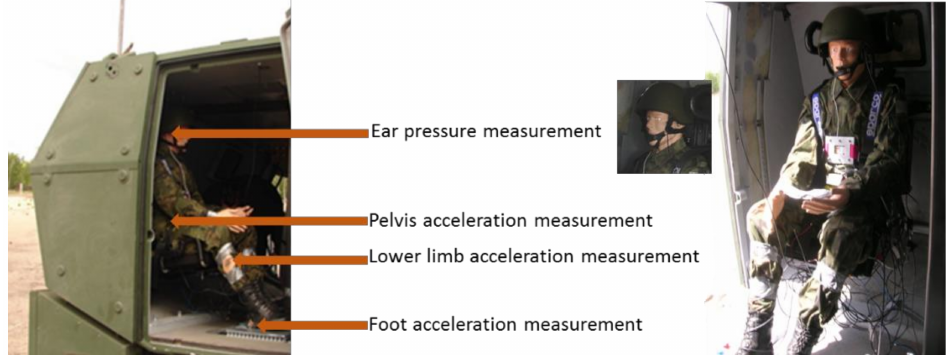
Figure 6. Research test stand presenting the points of attachment of MEMS acceleration and pressure sensors on the